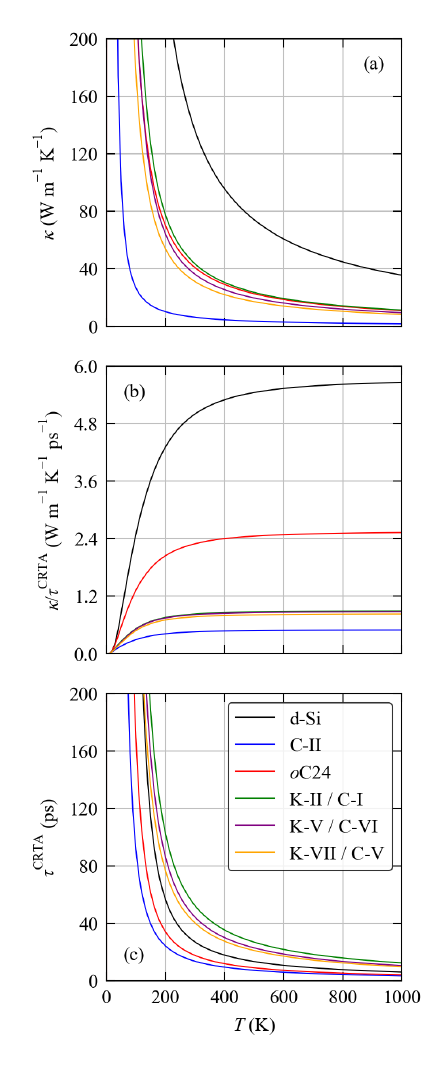
Figure 8. Calculated averaged lattice thermal conductivity of the six structures examined in this work: d-Si (black), C-II (blue), o C24 (red), K-II/C-I (green), K-V/C-VI (purple) and K-VII/C-V (orange). Subplot ( a ) shows the κ as a function of temperature, and subplots ( b , c ) show its decomposition into a harmonic term κ / τ CRTA and averaged lifetime τ CRTA using the constant-relaxation time approximation (CRTA) model defined in Equation (16) in the